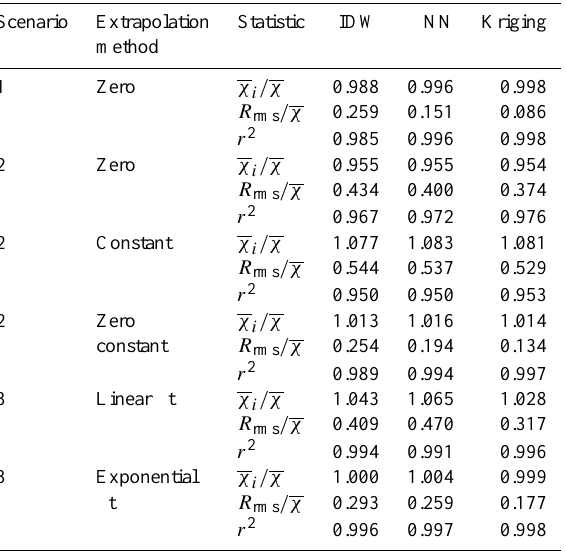
Table 4. Statistical comparison of interpolation techniques: inverse distance weighting (IDW), natural neighbour (NN) and kriging. The 20 August flight positions are used with three simulated emissions scenarios: (1) a single elevated plume; (2) two overlapping elevated plumes; and (3) a plume from a ground source. Different surface extrapolation methods are used based on the plume location (see Sect. 3.1). The statistics are determined using the interpolated mix- ing ratio χ i and the simulated mixing ration χ (from Eq. 13) as defined in the